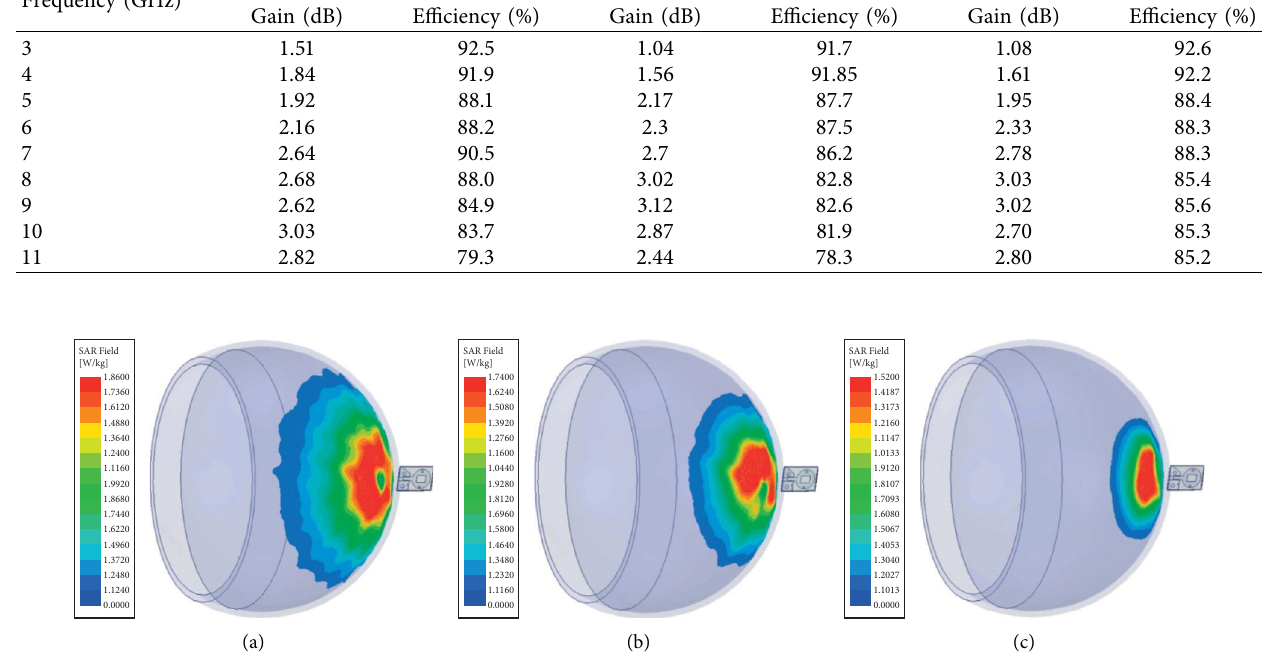
Figure 15: SAR analysis. (a) 4 GHz. (b) 6GHz. (c) 8 GHz. Table 4: Comparison with existing